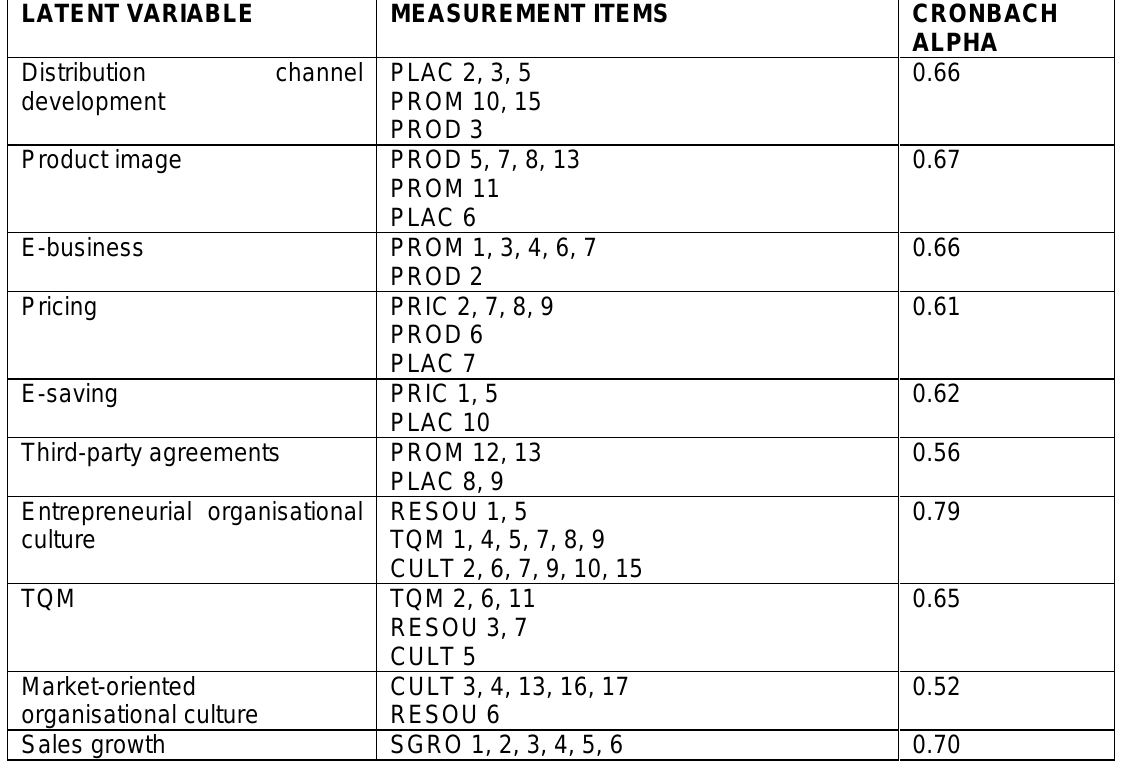
Table 4: empirical factor structure of the latent variables LATENT